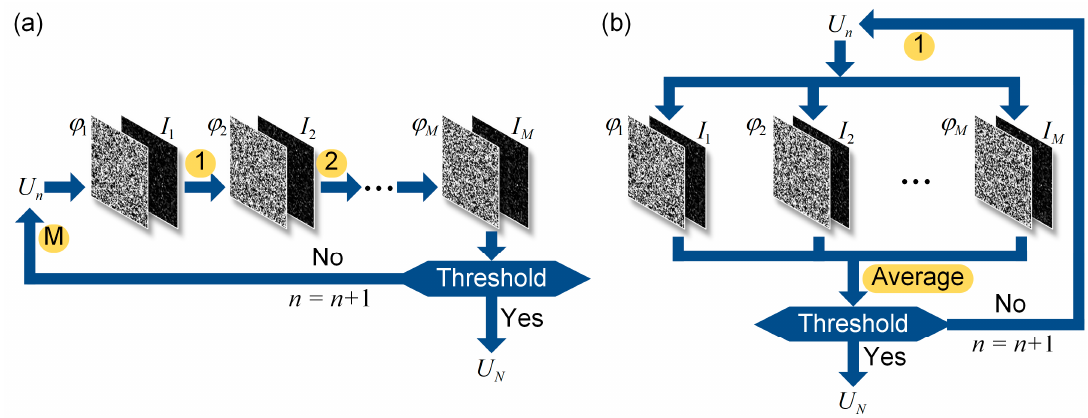
Figure 2. Reconstruction framework of serial and parallel algorithms: ( a ) the serial framework; ( b ) the parallel framework. Numbers in the yellow circles indicate the update times of U n in one iteration.